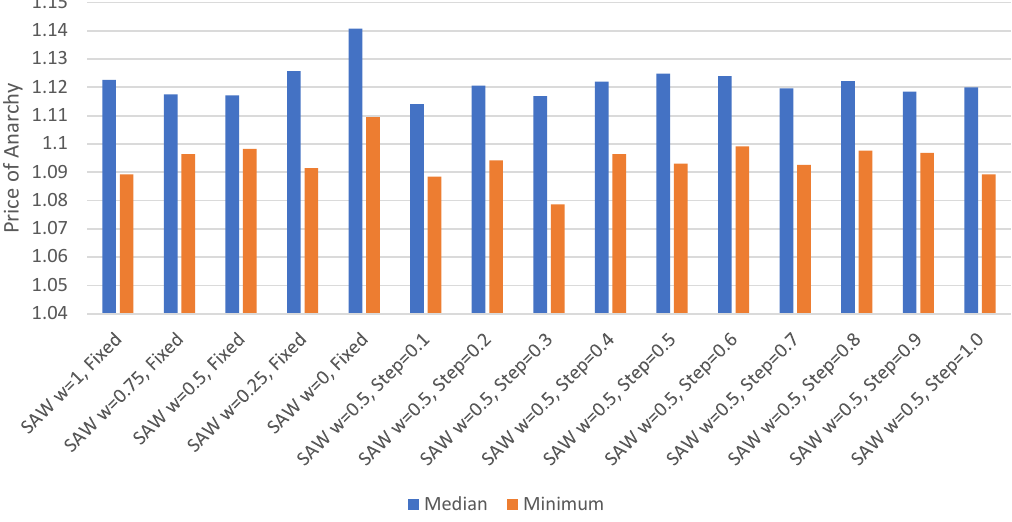
Figure 5. Minimum/median price of anarchy with TIS, no